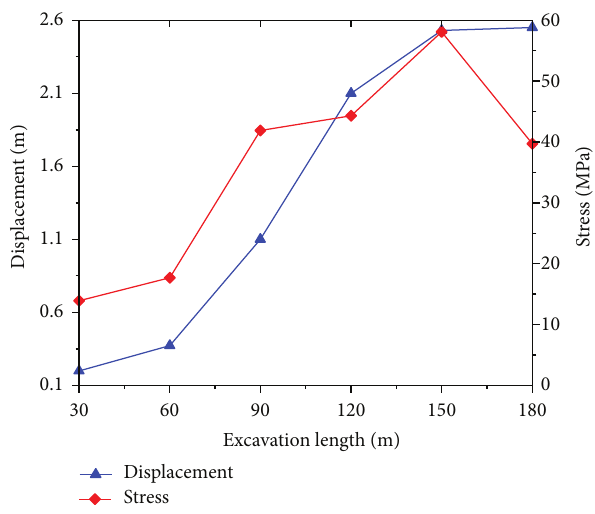
Figure 5: Plot of first principal stress and displacement of key stratum with excavation length.